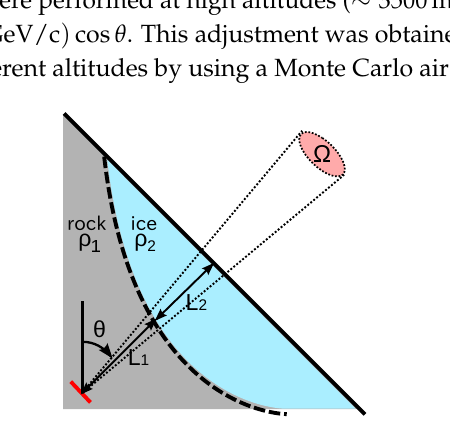
Figure 1. Schematic view of muon radiography at glacier environments.